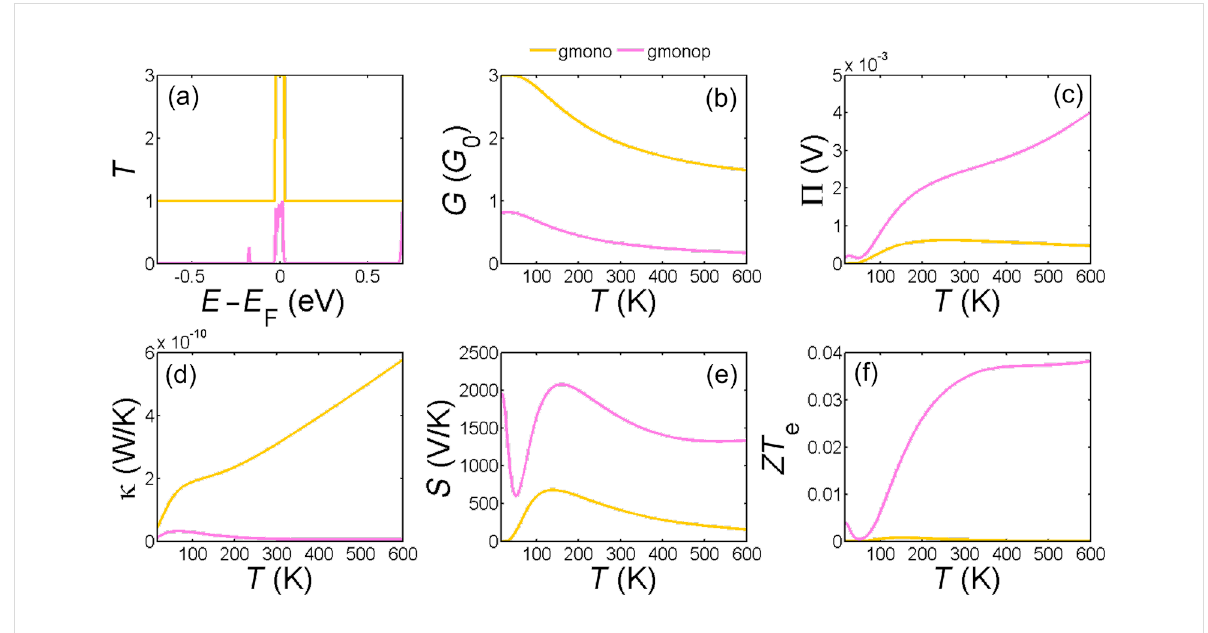
Figure 2: (a) Transmission coefficient T ( E ); (b,c) electrical and thermal conductance ( G , κ ), (d,e) Peltier ( П ) and Seebeck ( S ) coefficients and (f) figure of merit as a function of the temperature in zigzag monolayer graphene nanoribbon (gmono) and monolayer graphene nanopore